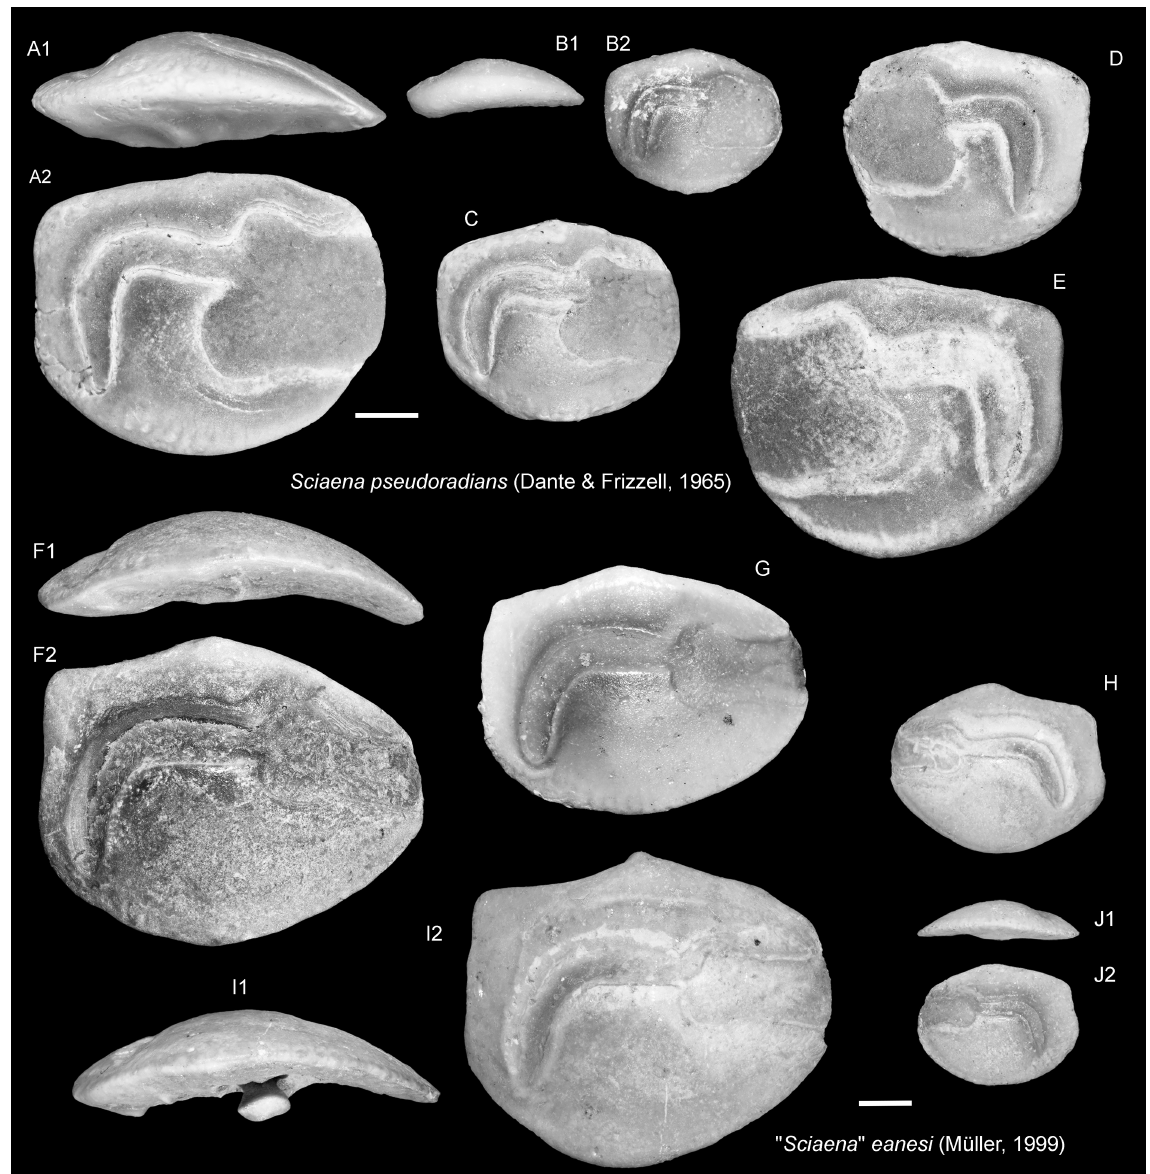
Fig. 34. Fish otoliths from the US middle and upper Eocene. A–E . Sciaena pseudoradians (Dante